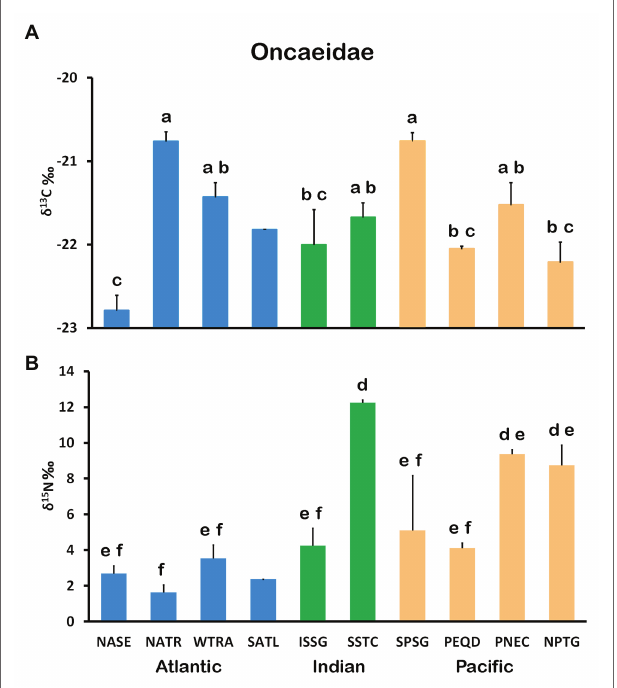
FIGURE 2 | Mean and SE values of δ 13 C (A) and δ 15 N (B) for Oncaeidae by Longhurst Provinces. Groups of significantly different means (ANOVA and Bonferroni post hoc test, p < 0.05) are indicated by different letters (a, b, c, d, e, and